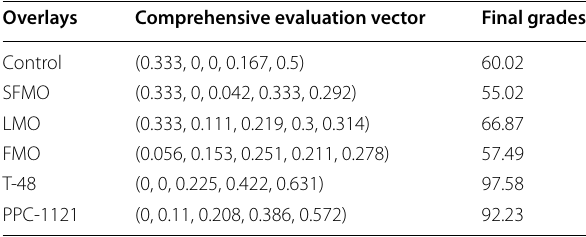
Table 11 Comprehensive evaluation vector and final grades of overlays in OR Overlays